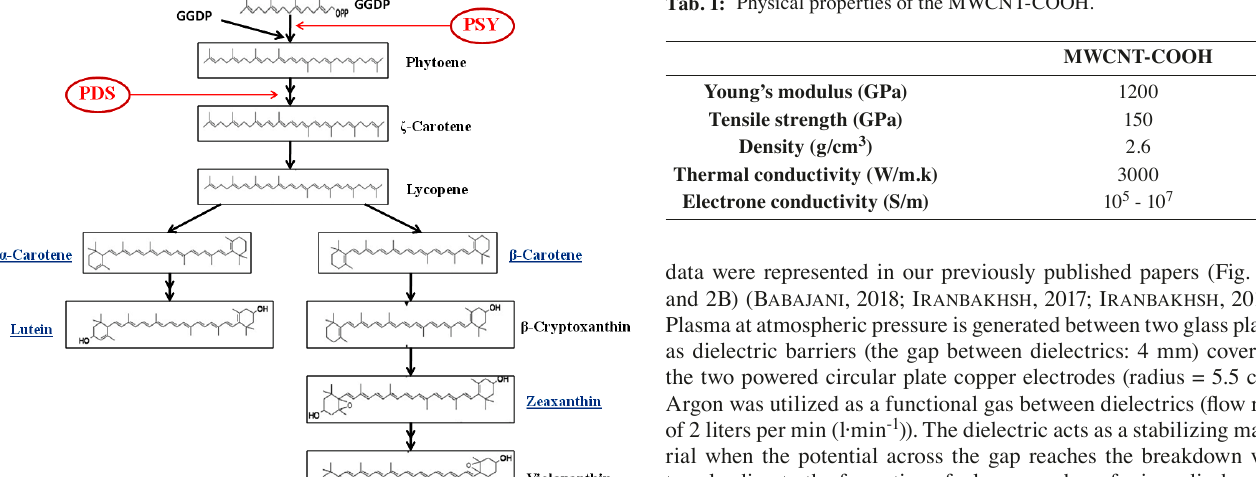
Treatment of seeds using CNT and cold plasma and